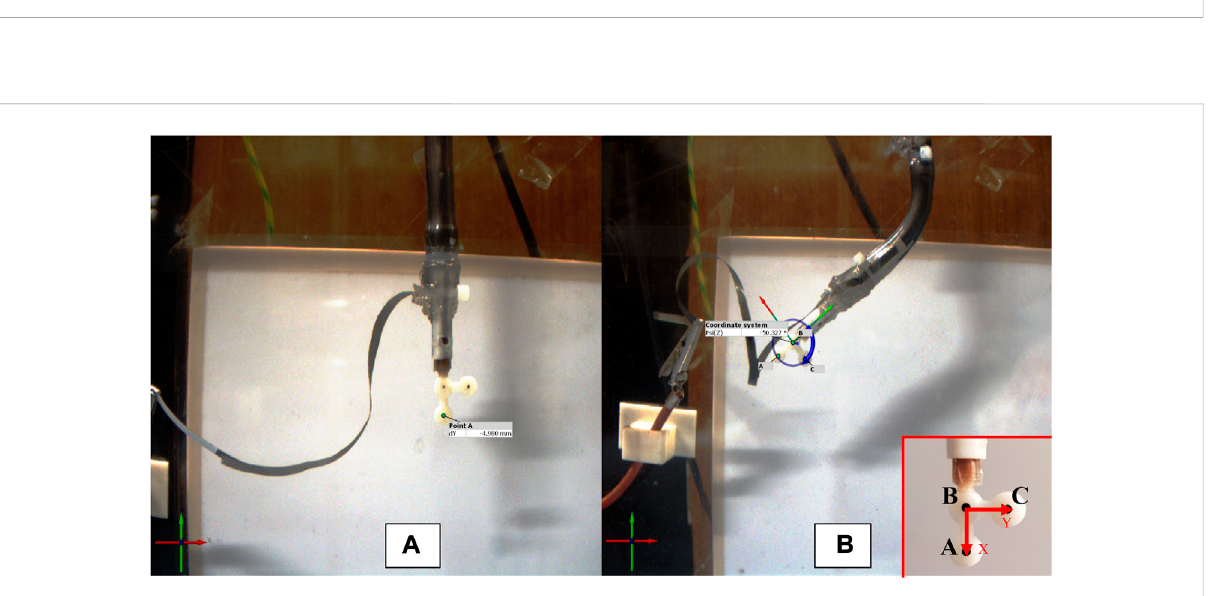
FIGURE 9 Marker recognition dot used in the deformation tests of linear-type DE actuator (A) and bending-type DE actuator (B)